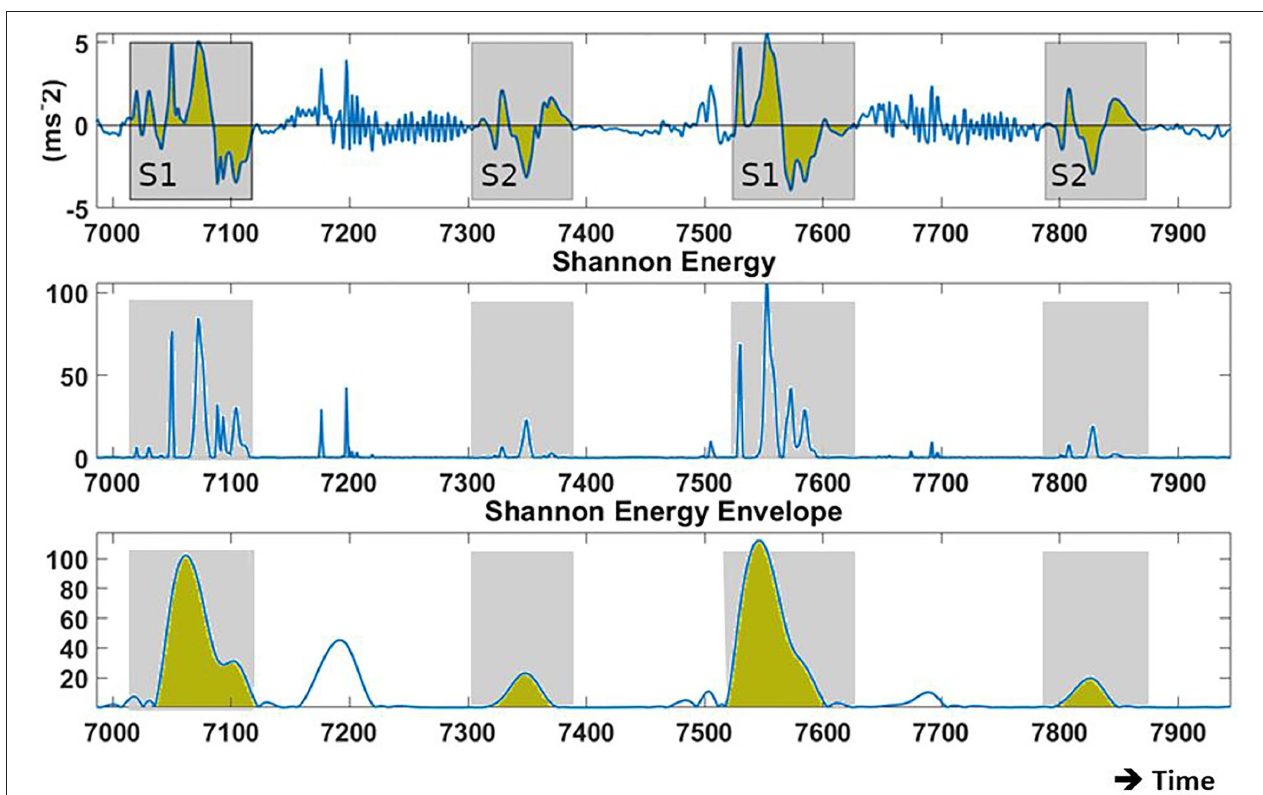
FIGURE 3 | Examples of the recorded baseline acceleration signal (Bi-Ventricular (BIV) pacing, Atrio-Ventricular (AVd): 150ms) and its Shannon energy from which training features are derived. (Top) acceleration during two cardiac cycles in proximity to the mitral valve. (Center) Shannon energy of the original signal, pronouncing low intensity amplitudes over high intensity amplitudes. (Bottom) Displays the envelope based on the Shannon energy. Blue line = raw signal; Yellow area = signal integral; Gray area = region for feature